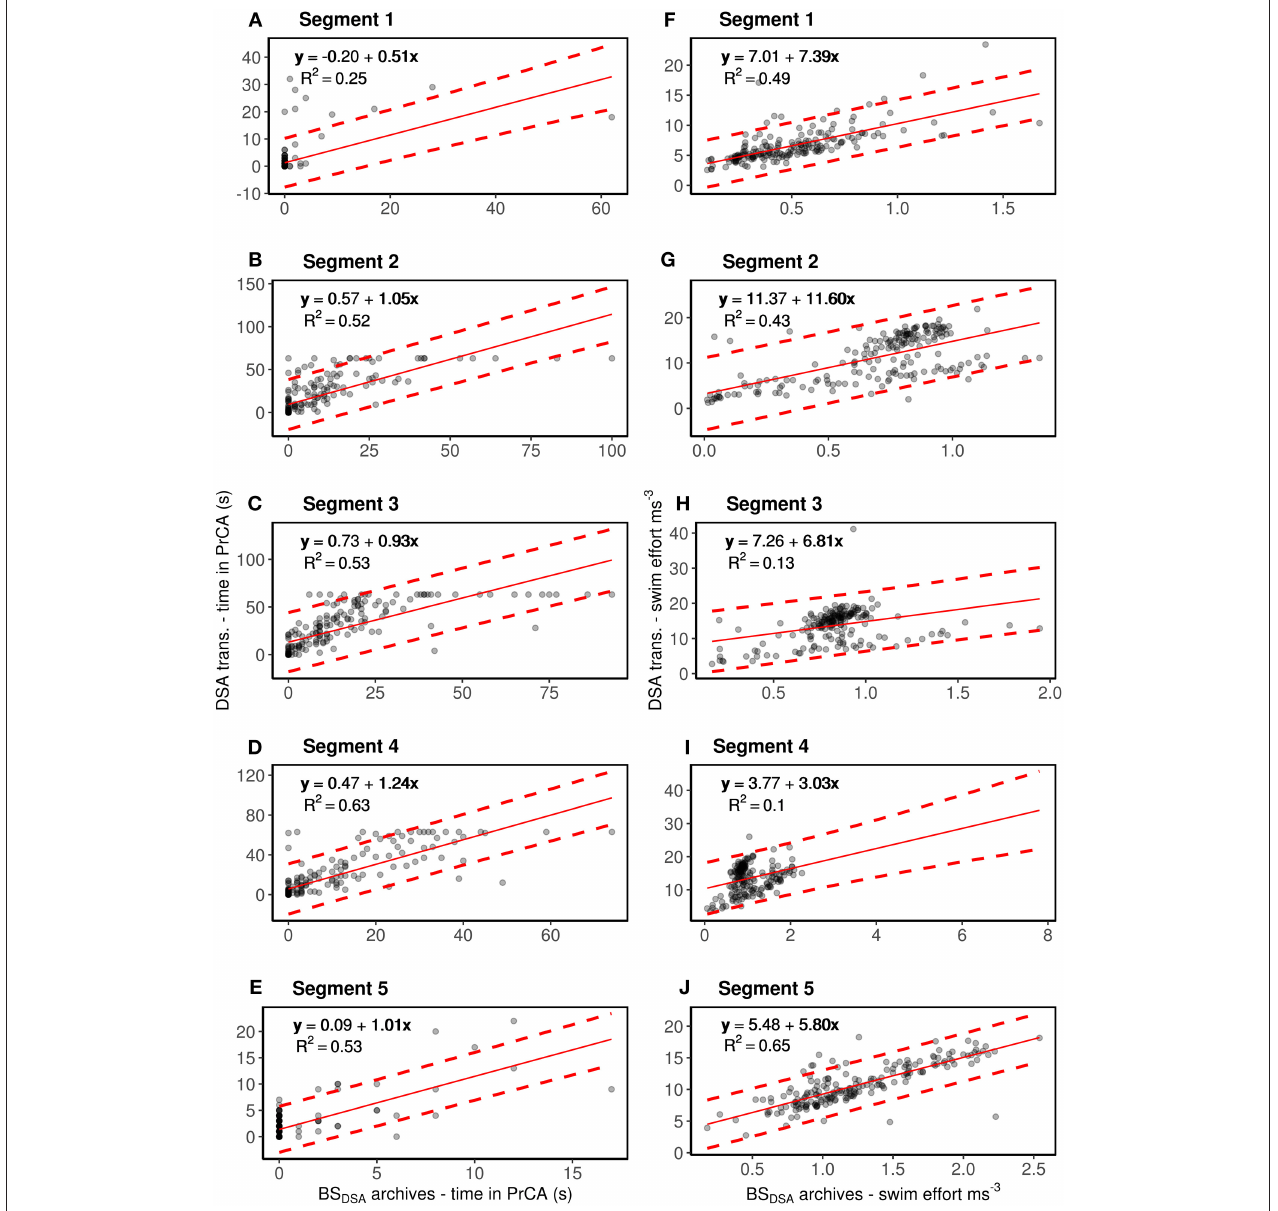
FIGURE 3 | Segment by segment comparisons between DSA transmissions of time spent in PrCA behaviors (column one; A–E ) and swimming effort (column 2; F–J ) to estimates from the corresponding BS DSA summarized archives (for one individual #143468). The red line represents the intercept-slope output, with 95% prediction intervals in dashed red. Intercept and slope values close to 0 and 1, respectively reflect stronger correlations/likeness between the two data types than those far from 0 to 1. R 2 values show the amount of variation accounted for by the model. Rows, from top to bottom, correspond to segments one through to five.